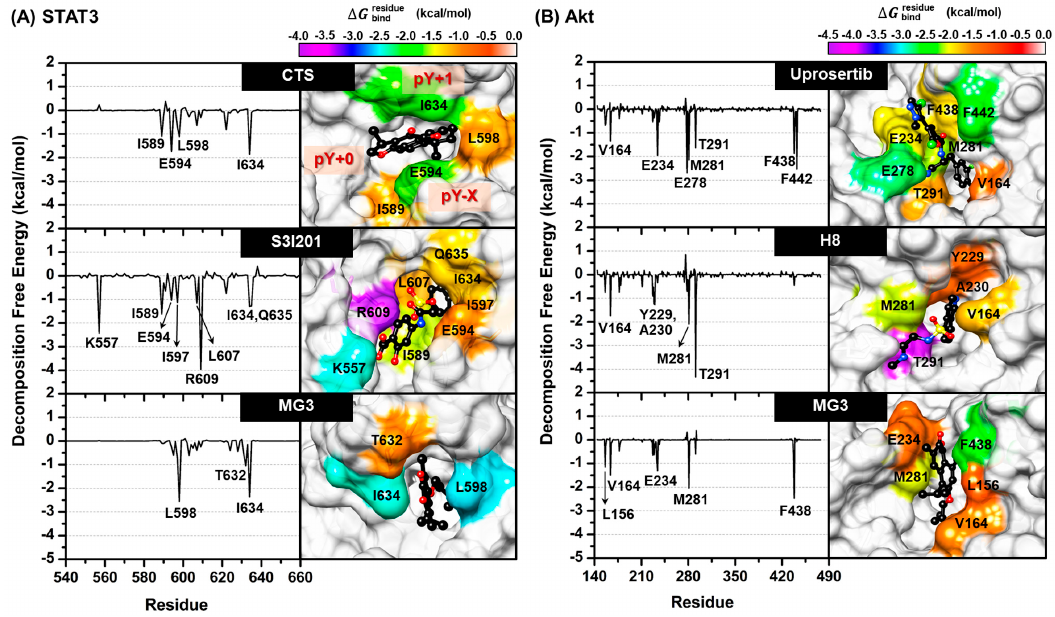
Figure 5. ∆ G residue (kcal/mol) of ( A ) STAT3 and ( B ) Akt. The amino acids involved in ligand binding Figure 5. ∆ G bindresidue (kcal / mol) of ( A ) STAT3 and ( B ) Akt. The amino acids involved in ligand binding bind are shaded according to their ∆ G residue , in which the highest and lowest energies are ranged from red are shaded according to their ∆ G bindresidue , in which the highest and lowest energies are ranged from bind to magenta, red to magenta, respectively.